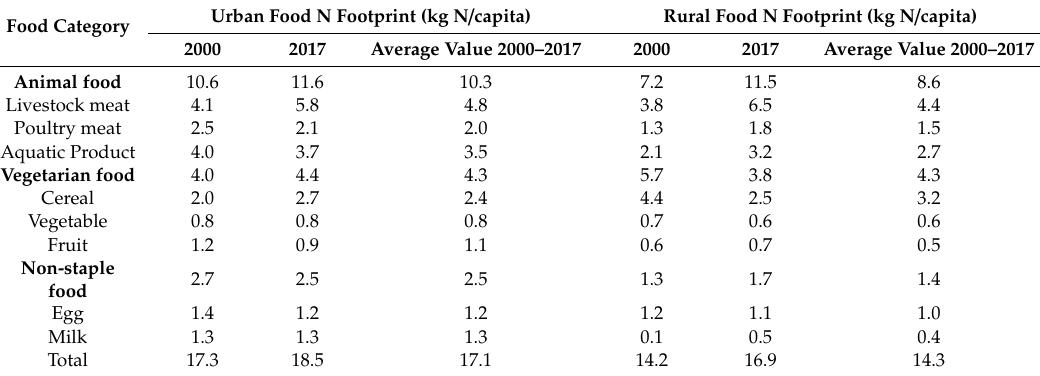
Table 2. The food N footprints of residents in Shanghai in 2000, 2017, and the average value from 2000 to 2017. Food Category